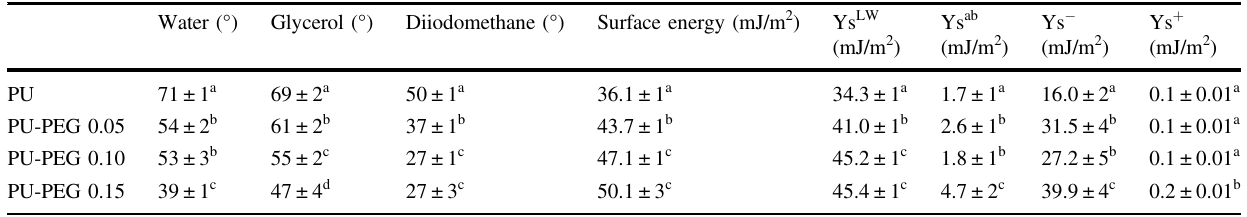
Table 2 Contact angles and surface free energy components of the fi lms as determined by the method of van Oss and Good Water (°) Glycerol (°) Diiodomethane (°)